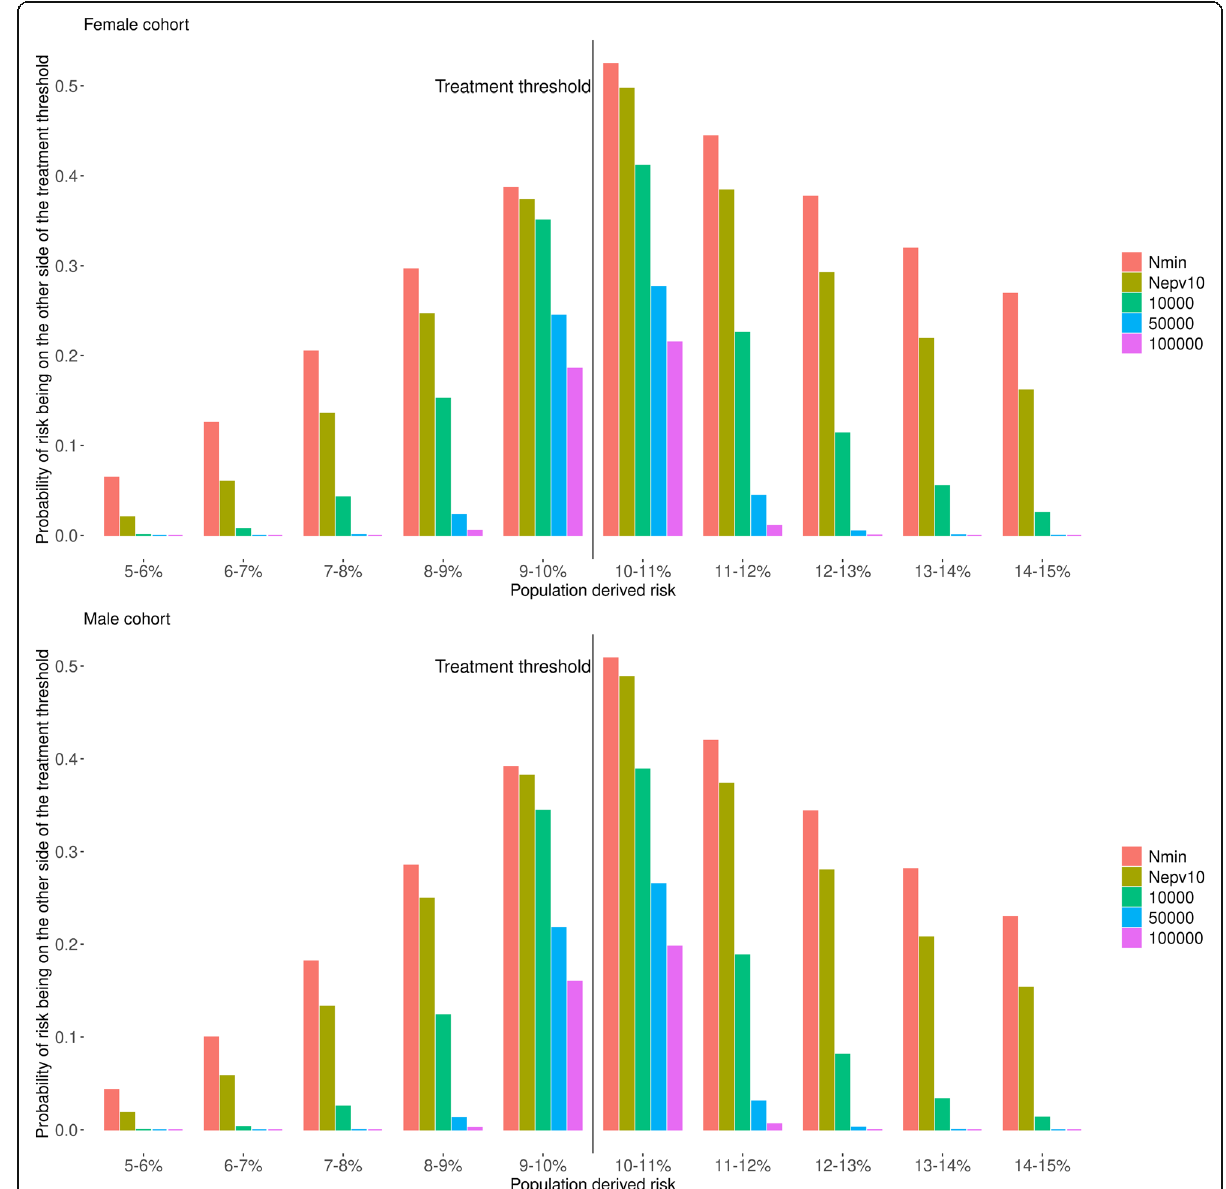
Fig. 6 Probability of being classified on the opposite side of the 10% risk treatment threshold. This is the probability that a patient from a specified given population-derived risk group would be classified on the opposite side of the 10% treatment threshold by a randomly selected